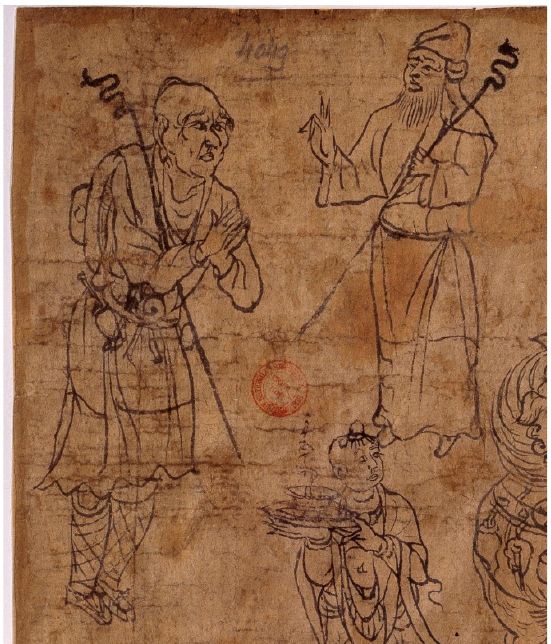
Figure 10. Ma ñ ju ś r ī and Four Assistants (detail). Dunhuang , 9th–10th century. Ink on paper, 30.6 × 42.5 cm. Bibliothèque nationale de France (Pelliot chinois 4049).